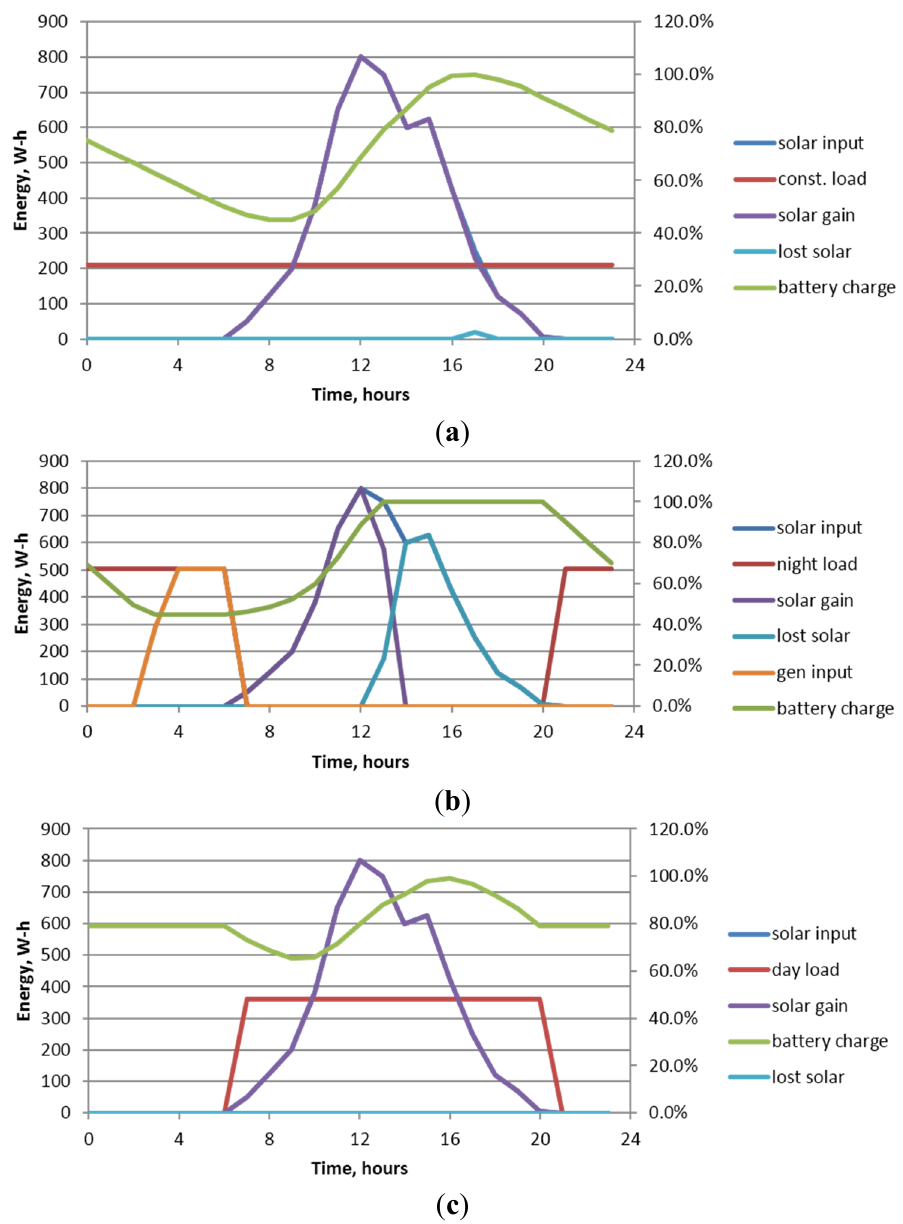
Figure 3. ( a ) Energy flows and state of battery bank charge for sunny day with constant electrical load over 24 hours; ( b ) Energy flows and state of battery bank charge for sunny day with constant electrical load concentrated during nighttime hours; ( c ) Energy flows and state of battery bank charge for sunny day with constant electrical load concentrated during daylight